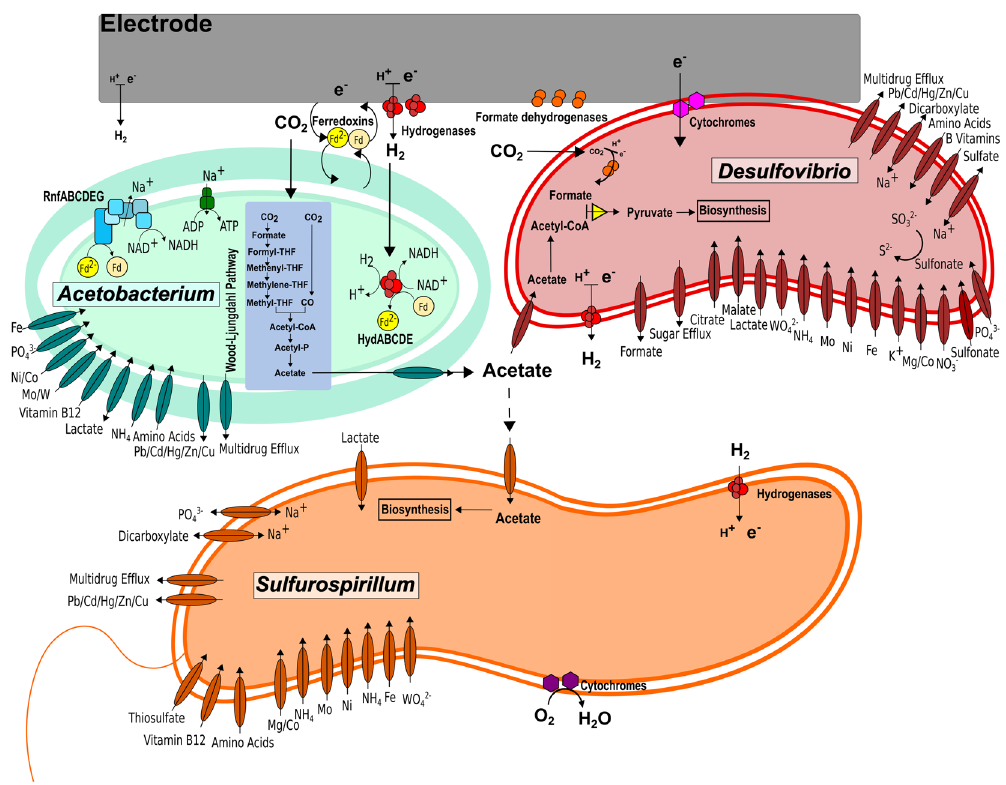
Figure 5. Hypothetical model of key metabolic activities and interactions among dominant members of the electrosynthetic microbial